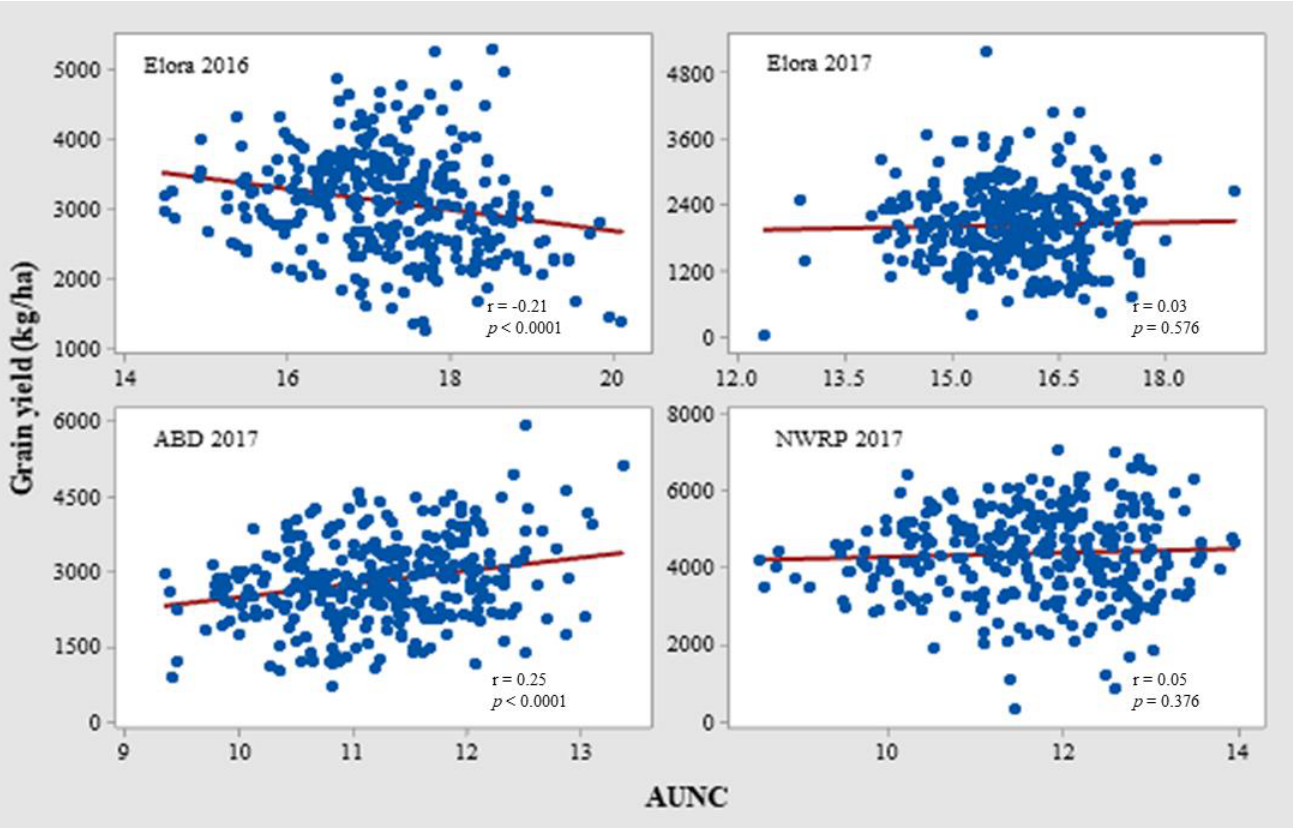
Figure 3. Scatter plots of AUNC with grain yield from four field experiments conducted in 2016 and 17. Trend line indicates a Pearson Correlation line of best fit; Abbreviation: AUNC = Area under NDVI curve.